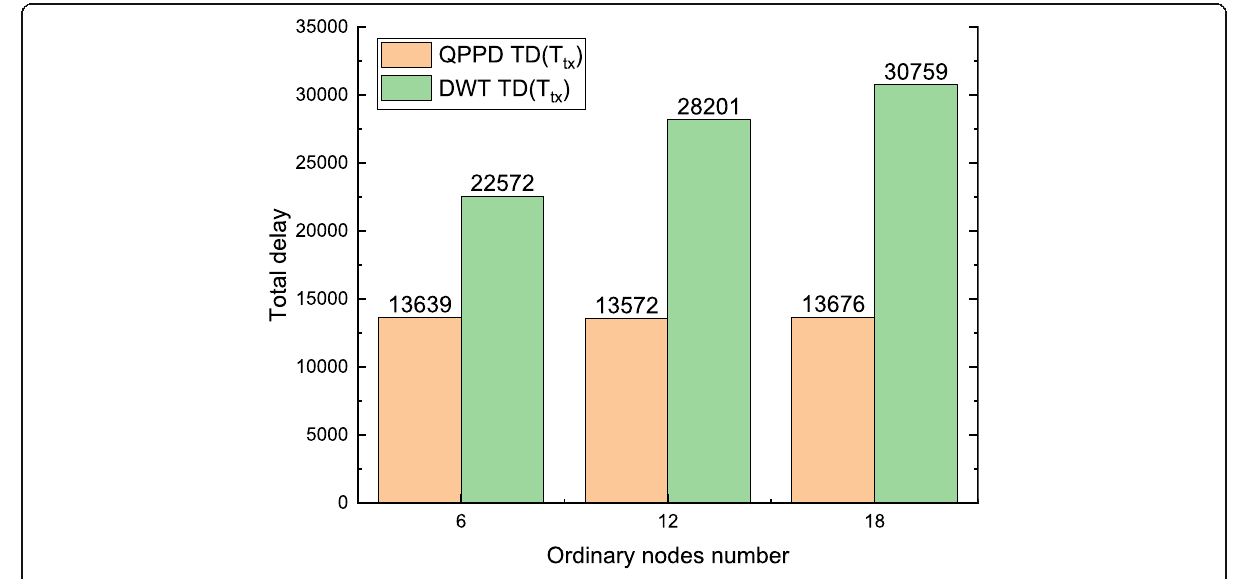
Fig. 39 The total volume of data randomly changes from 0 to 12; the total delay